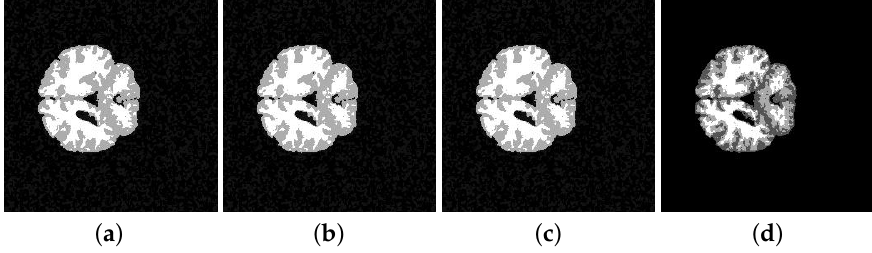
Figure 10. Segmentation of the noised Image 205-3 using K-means ( a ) FCM ( b ) SFCM ( c ) and KFCM ( d